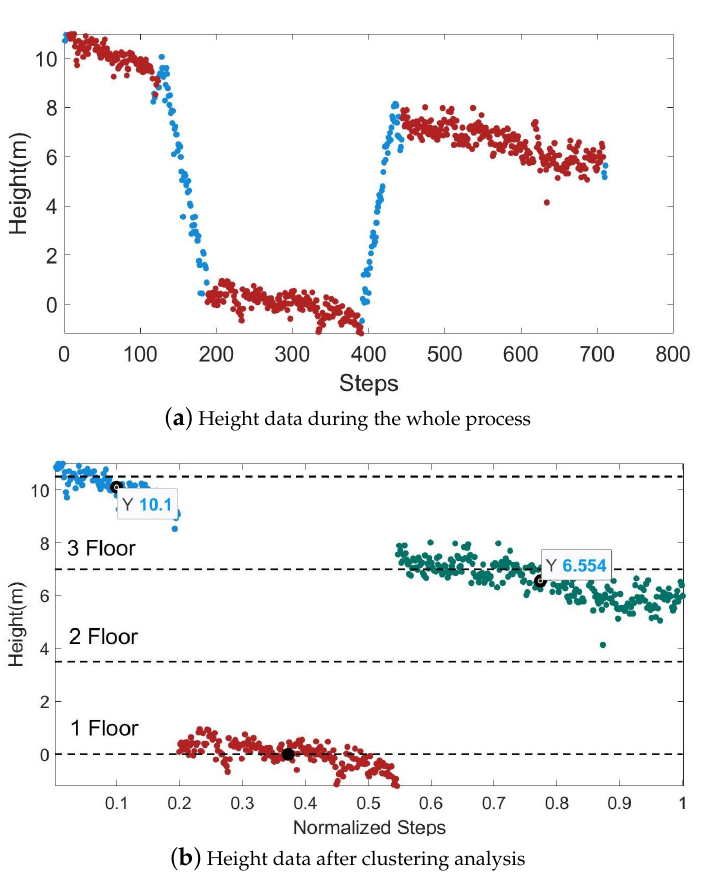
Figure 10. Schematic diagram of the barometer’s height correction process in 3D